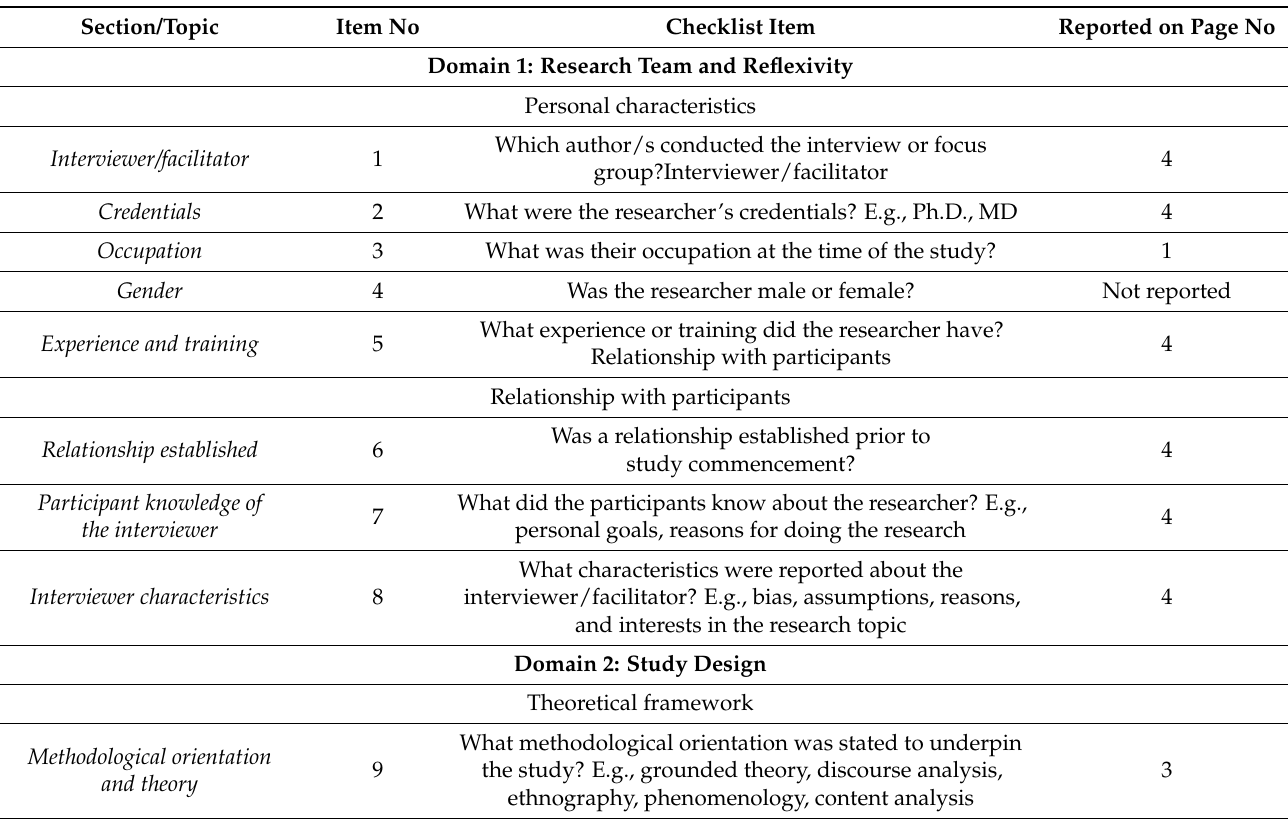
Table A1. The COREQ Checklist, as reported in